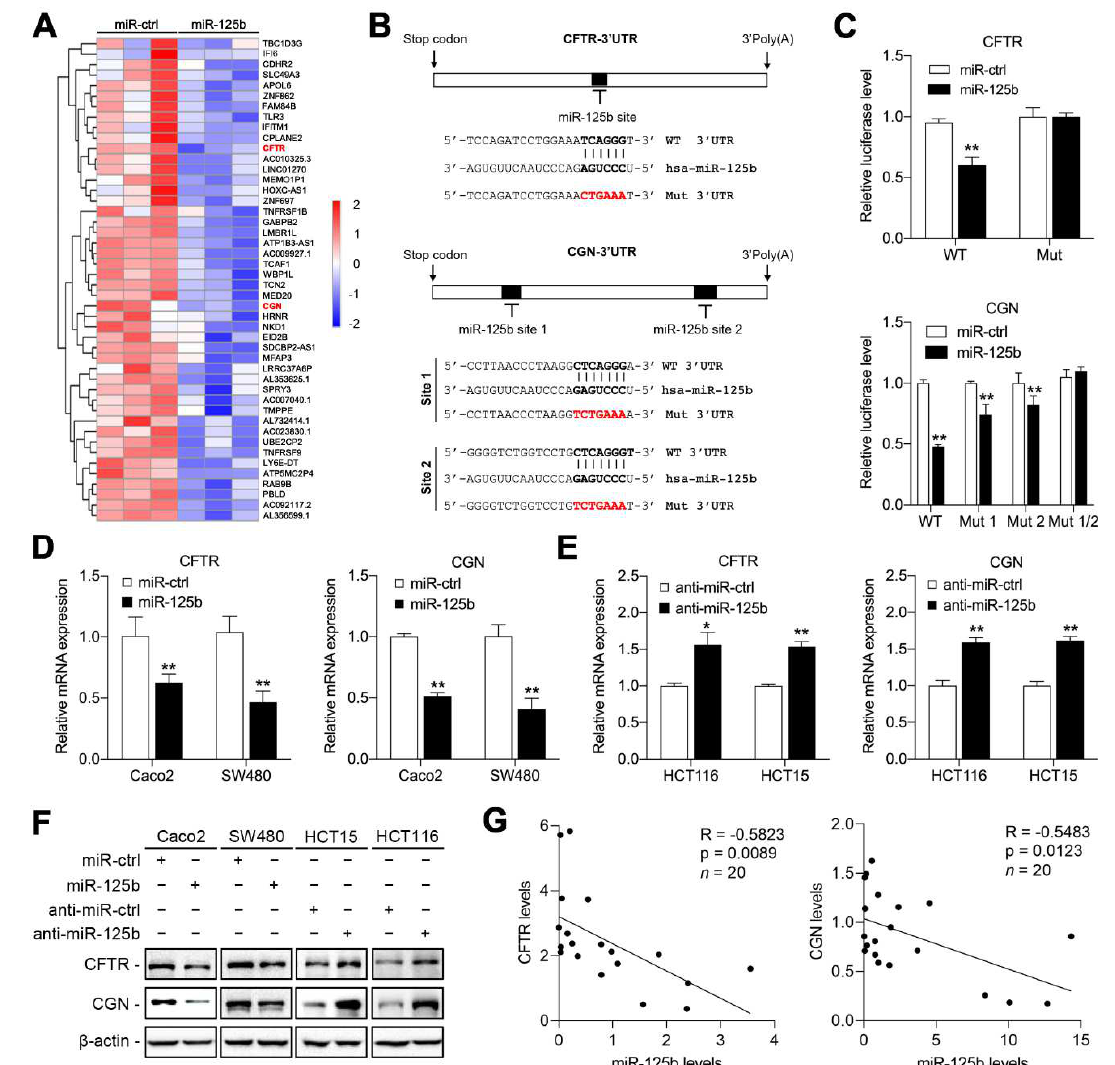
Figure 3. Cystic fibrosis transmembrane conductance regulator (CFTR) and cingulin (CGN) are direct targets of miR-125b. ( A ) Heatmap showing the 46 downregulated genes in Caco2 cells after transfection of miR-125b. The scale bar shows color-